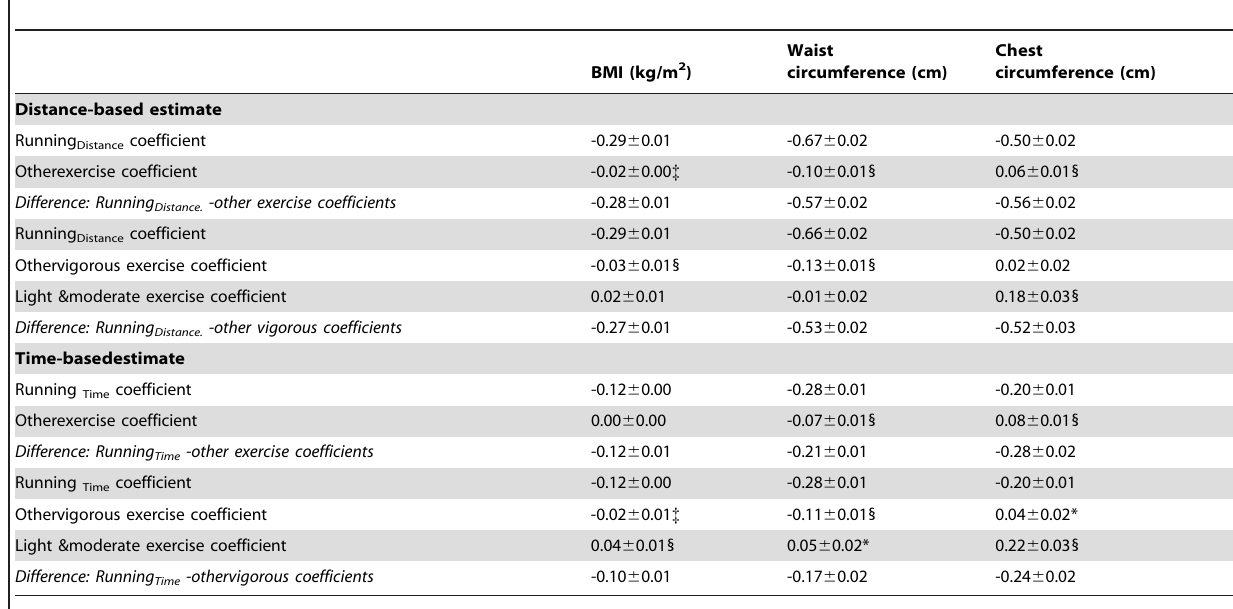
Table 2. Cross-sectional regression slopes ( 6 SE) of BMI and body circumferences (dependent variables) versus MET hours per day of running and other physical activities (independent variables) in